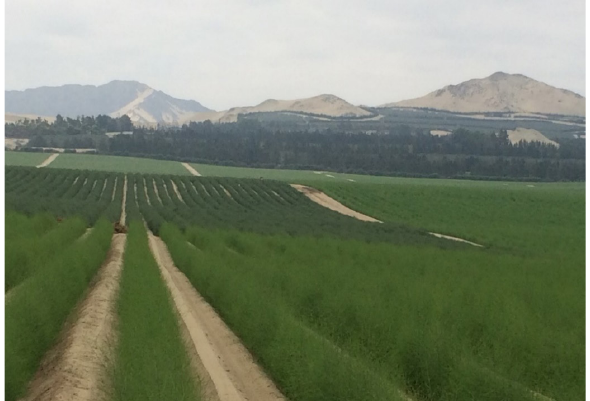
Figure 1 . Asparagus plantation in the Chavimochic Irrigation